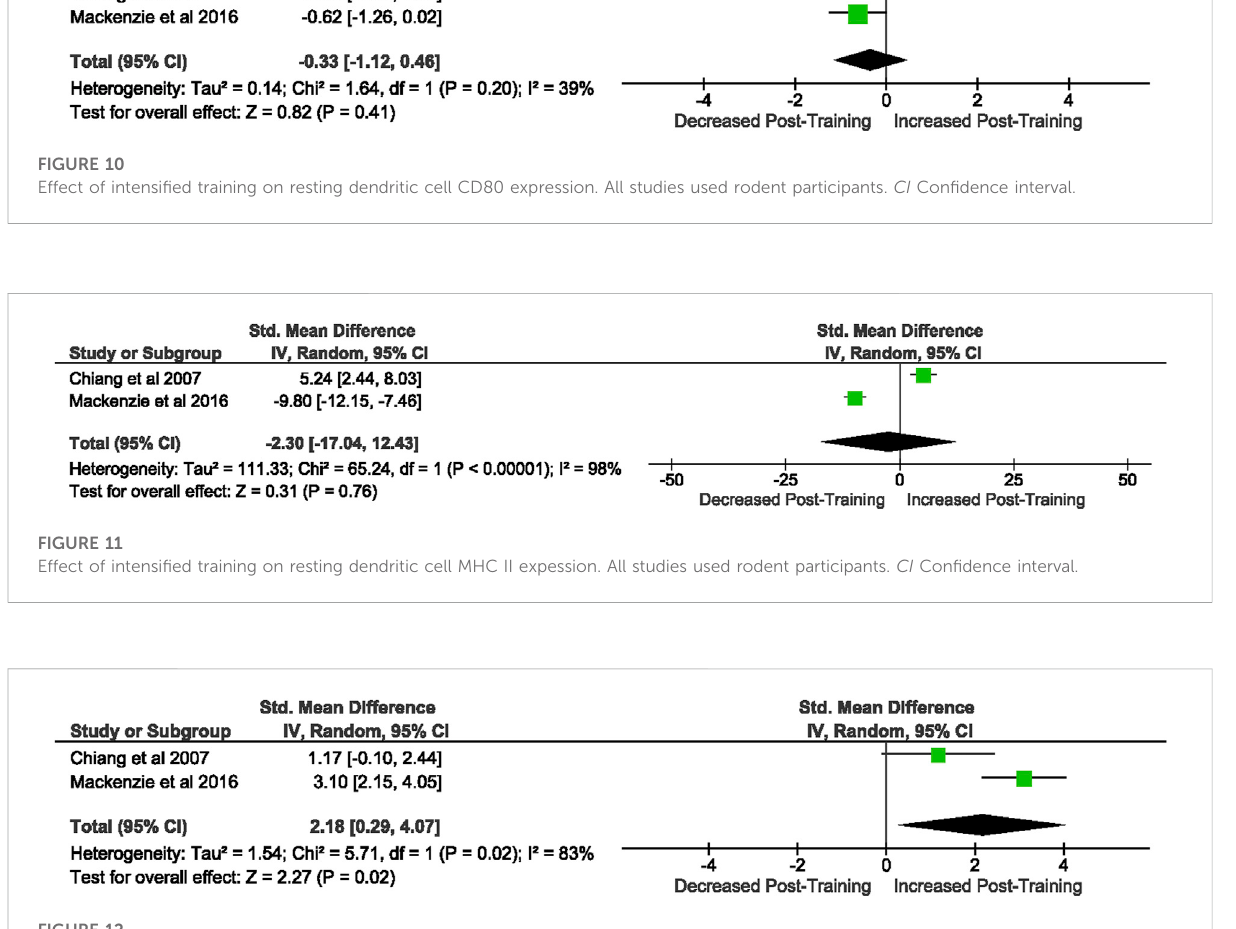
FIGURE 12 Effect of intensi fi ed training on resting dendritic cell CD86 expression. All studies used rodent participants. CI Con fi dence